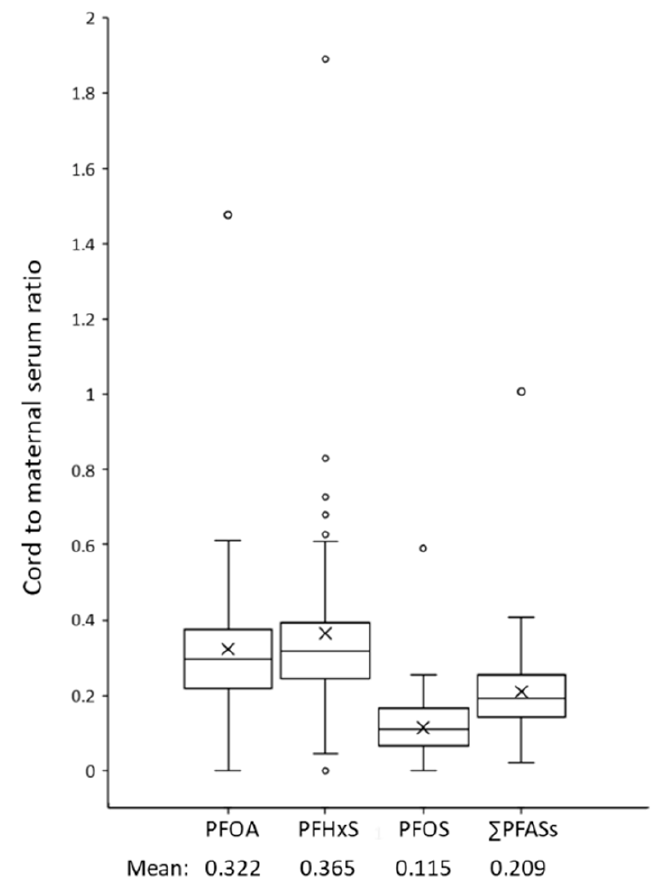
Figure 2. Box plots showing distribution of placental transfer rate (cord to maternal serum ratio) of perfluoroalkyl substances (PFASs) in the study population ( n = 62). Median (line within box), first and third quartiles (bottom and top of box, respectively), 5th and 75th percentiles (lower and upper bars, respectively), and arithmetic mean (X) are shown.